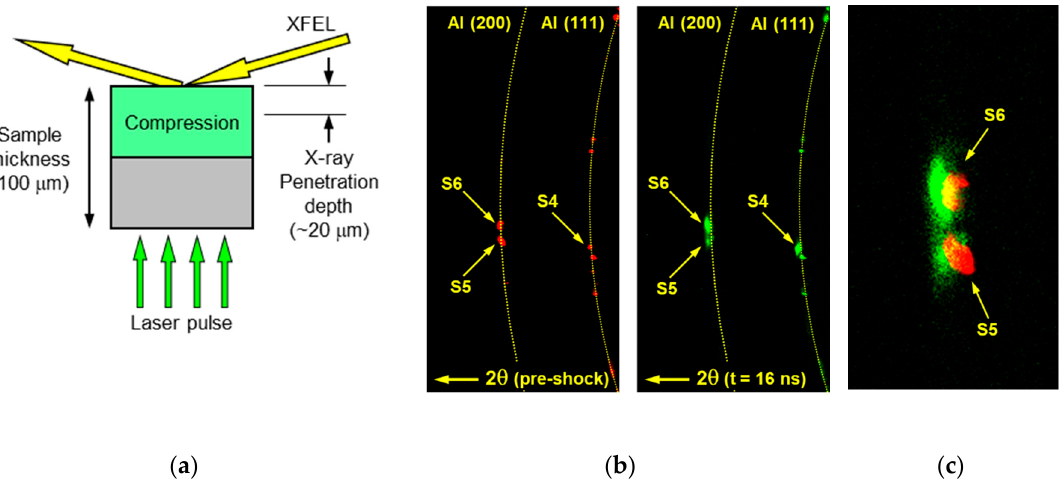
Figure 19. Di ff racted XFEL patterns of the solution heat-treated A6061 aluminum alloy at 16 ns after Figure 19. Diffracted XFEL patterns of the solution heat-treated A6061 aluminum alloy at 16 ns. laser pulse irradiation: ( a ) The position of the stress wave; ( b ) di ff raction patterns before and after laser irradiation; ( c ) superimposition of di ff raction spots “S5” and